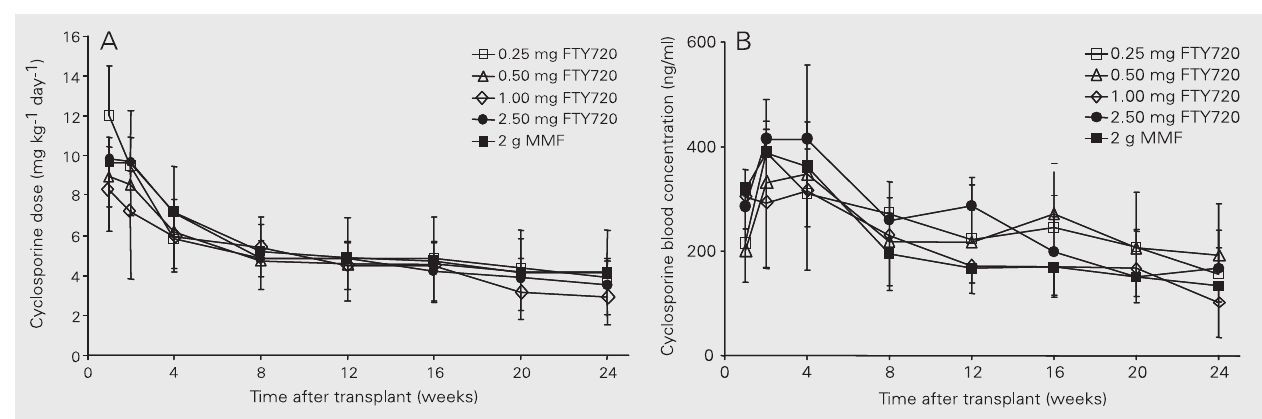
Figure 1. Time course of mean cyclosporine doses (A) and blood concentrations (B). There were no significant differences for mean cyclosporine doses or blood concentrations among study groups at each visit (independent Student t -test). MMF = mofetil